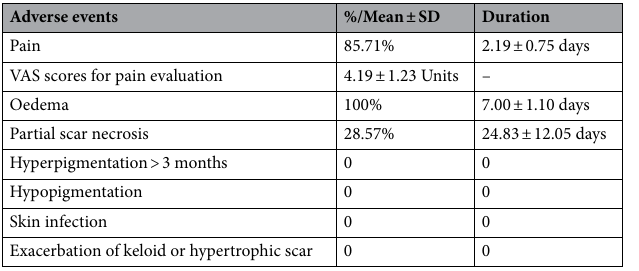
Table 4. Adverse events after treatment using intralesional 1470 nm bare-fibre diode laser. SD standard deviation, VAS visual analogue